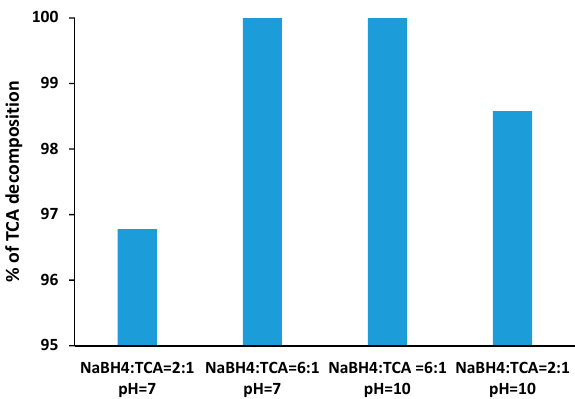
Figure 7. Decomposition of TCA after 2 h reductive dehalogenation over 70:30 SilverSil xerogel in TCA reductive dehalogenation at different pH and with NaBH 4 as reducing agent in 2:1 and 6:1 molar ratio, [TCA] = 1.4 × 10 − 3 M.